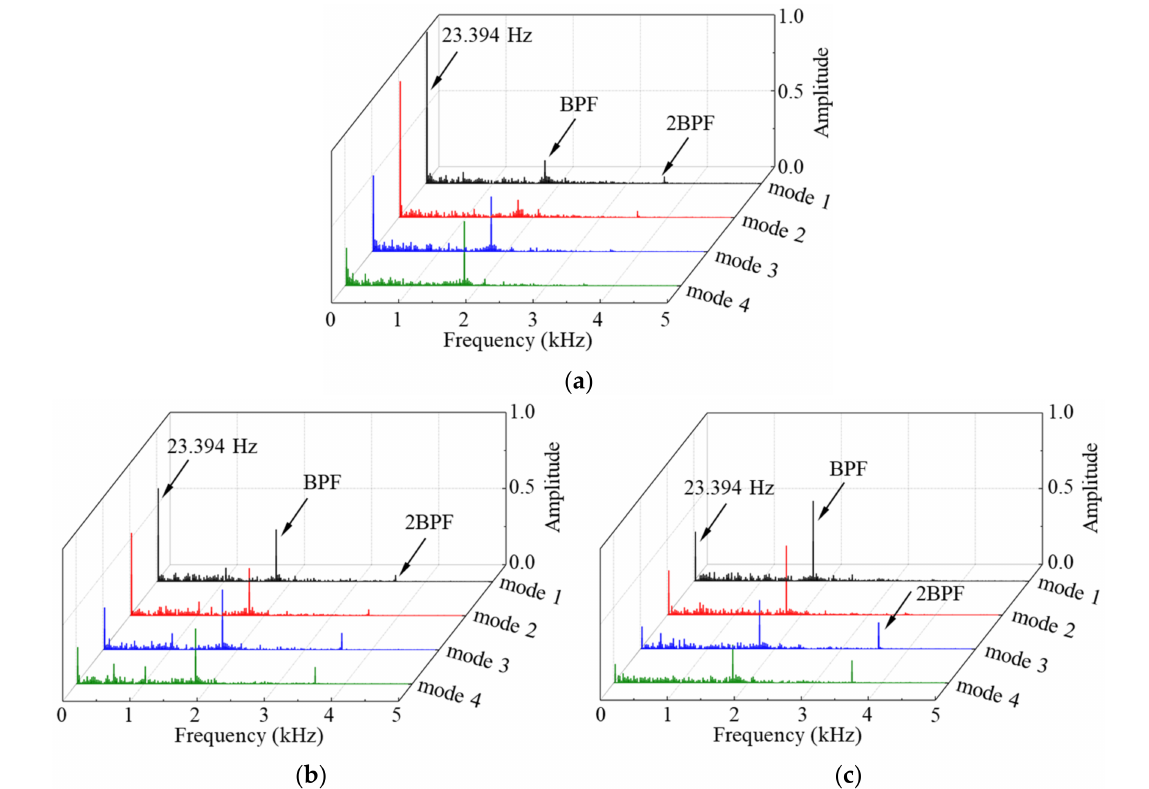
Figure 15. Spectrum analysis of modal coefficients for the POD modes of pressure fields in the diffuser (97% span, ϕ = 0.0833), ( a ) IGV30, ( b ) IGV45, ( c )